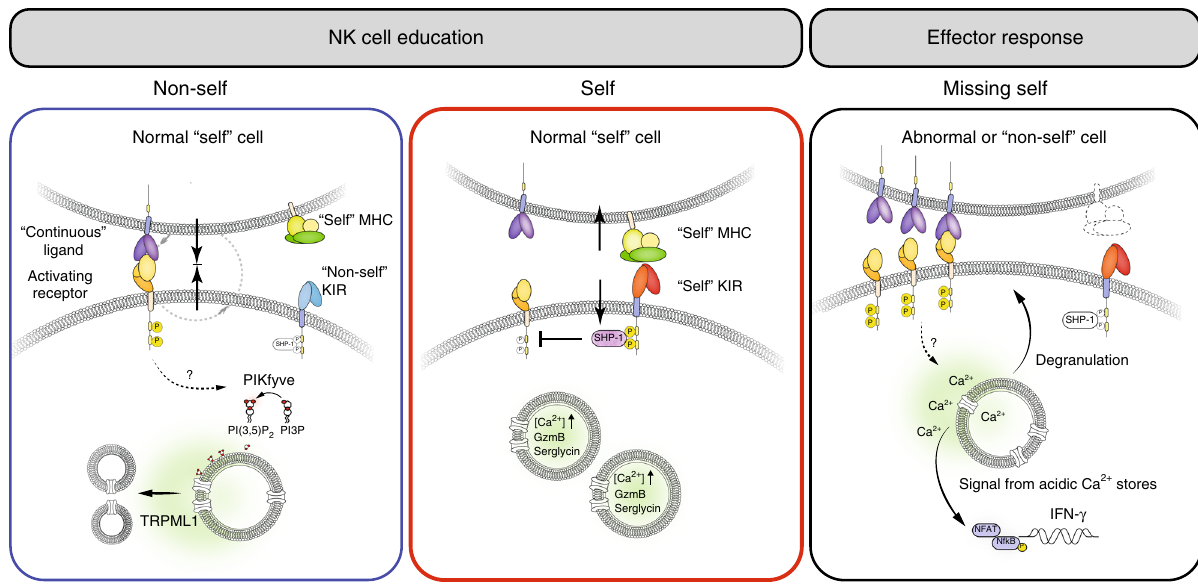
Fig. 8 Model describing the distinct fates of NK cells during NK cell education. NK cells lacking self-speci fi c receptors receive tonic stimulatory input through activating receptors and show poor functional responses, a process referred to as disarming 51 . We found that such cells exhibit lower levels of the granule matrix protein serglycin and effector molecules granzyme B and perforin and lack dense-core secretory lysosomes. One putative pathway downstream of activation receptor signaling is PI3K/AKT that stimulate the enzyme PIKfyve, which converts PI3P to PI(3,5)P 2 and thereby